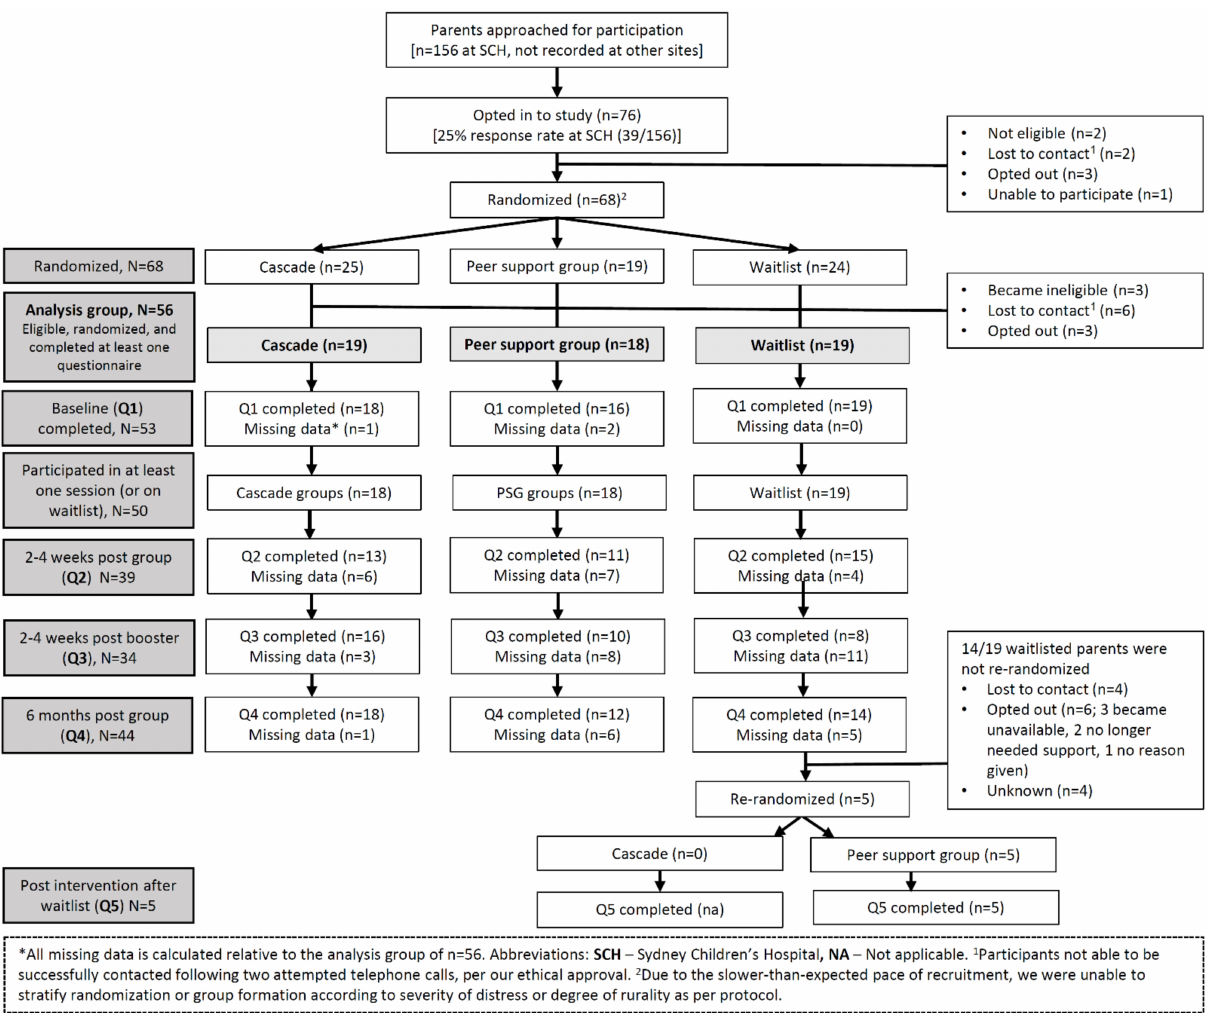
Figure 1. Rates of recruitment and retention over the course of the Cascade